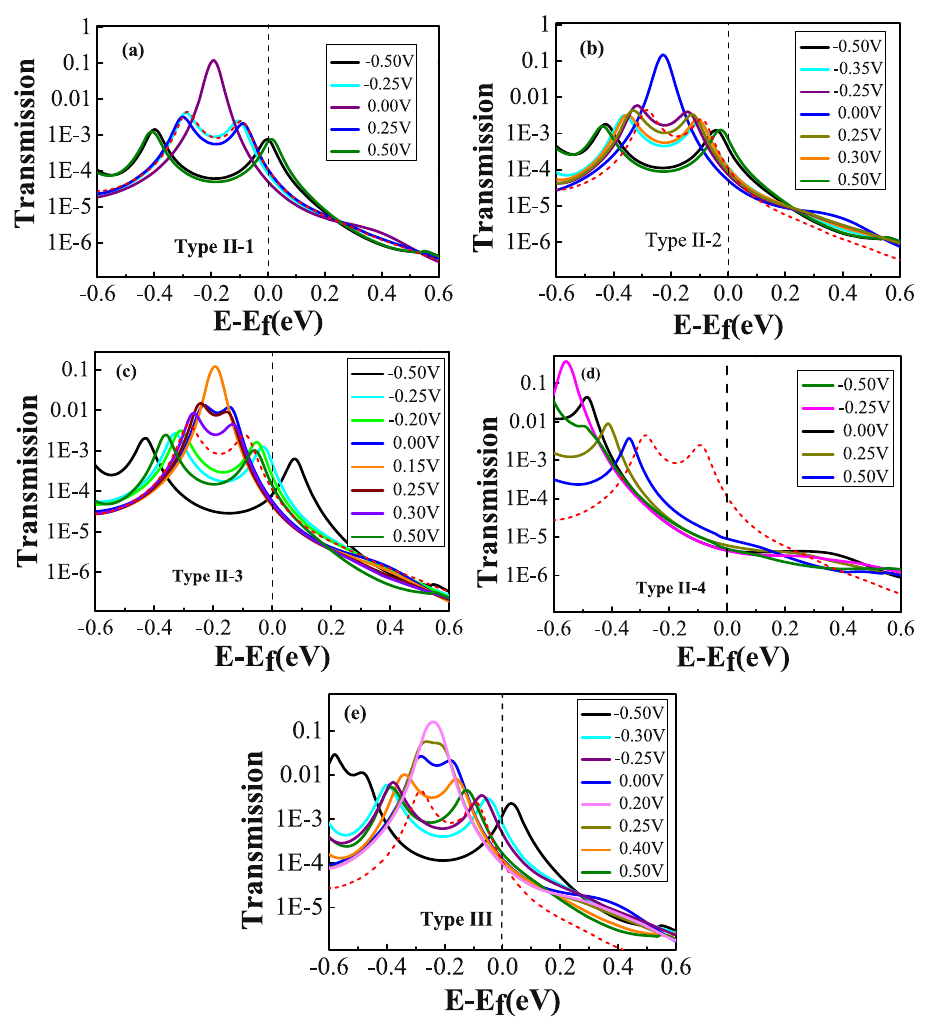
Figure 6. Transmission spectra of TADHA molecular junctions. ( a ), ( b ), ( c ) and ( d ) Transmission spectra for the molecular junction with two H 2 O adsorbates as Type II-1, 2, 3 and 4 molecular systems; ( e ) Transmission spectra for the molecular junction with three aggregated H 2 O molecules being adsorbed on as Type III molecular systems. The red dashed lines in ( a ), ( b ), ( c ), ( d ) and ( e ) are the transmission spectra of TADHA molecular junction without H 2 O adsorbate at 0.25 V bias voltage, which are used as reference curves in the